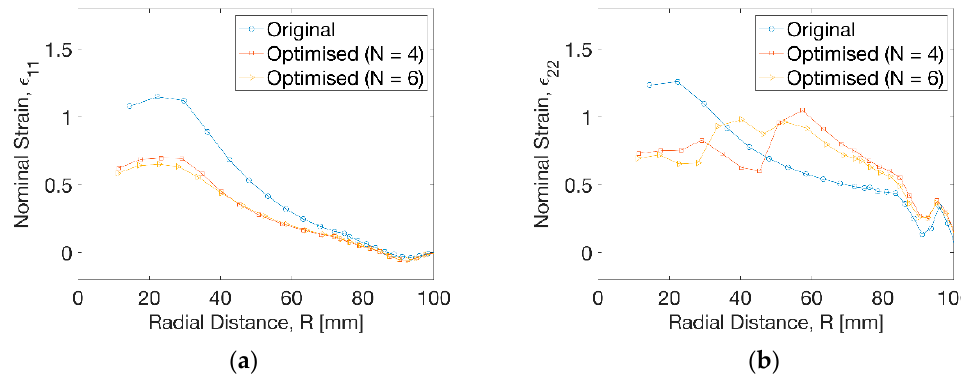
Figure 10. Strain distribution at different processing conditions. ( a ) Hoop strain, ( b ) axial strain.